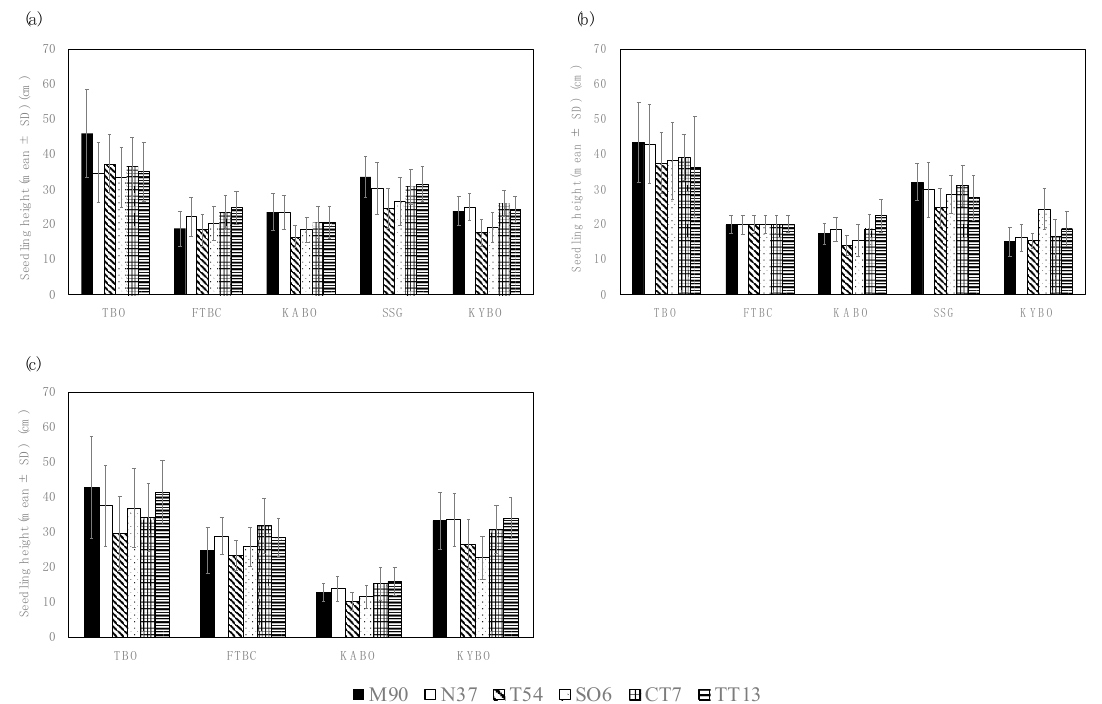
Figure 2. Mean seedling heights of P . thunbergii families before inoculation with PWNs in: ( a ) 2015, ( b ) 2016, ( c ) 2017. Error bars represent standard deviations (SD). Test site abbreviations: Tohoku Regional Breeding Office (TBO), Forest Tree Breeding Center (FTBC), Kansai Regional Breeding Office (KABO), Shikoku Breeding Stock Garden (SSG), and Kyushu Regional Breeding Office (KYBO). Family name abbreviations: Misaki 90 (M90), Namikata 37 (N37), Tanabe 54 (T54), Shizuoka (Oosuka) 6 (SO6), Chiba (Tomiura) 7 (CT7), and Tottori (Tottori) 13 (TT13).